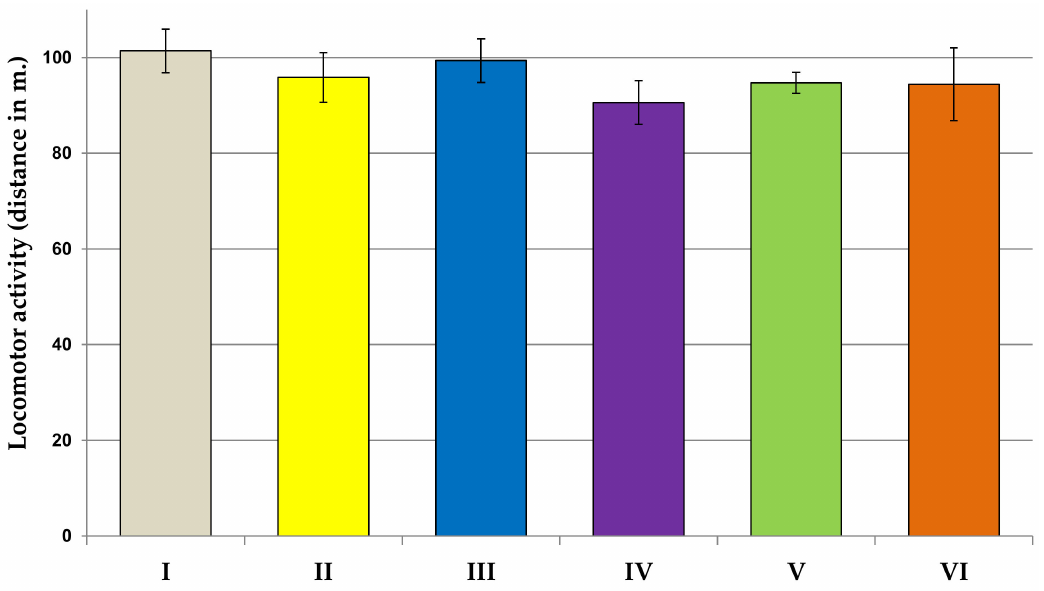
Figure 1. The influence of extracts on locomotor activity. All values are reported as mean ± SEM ( n = 7). I— aqua pro injectione ; II— Narcissus triandrus L. 20 mg/kg; III— Lycopodium clavatum L. 10 mg/kg; IV— Lycopodium annotinum L. 10 mg/kg; V— Huperzia selago L. 10 mg/kg; VI— Angelica dahurica (sp.) 200